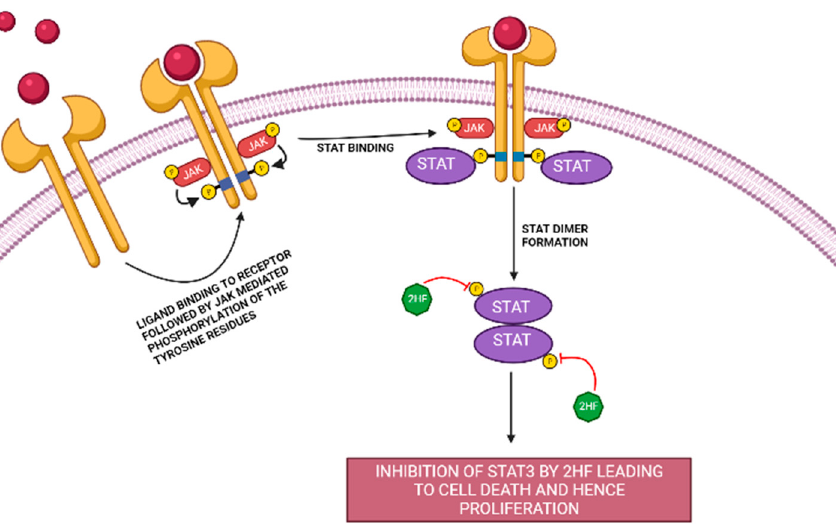
Figure 2. Upon binding of the ligand to the receptor, JAK phosphorylates the C-terminal end of STAT, and STAT forms an active dimer. 2 ′ -Hydroxyflavanone inhibits the phosphorylation of STAT and leads to apoptosis of cancer cells) [22].